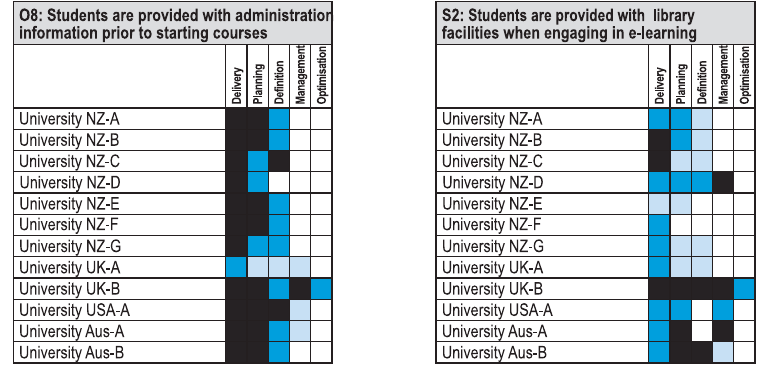
Figure 4. University process O8 and S2 capabilities (Marshall